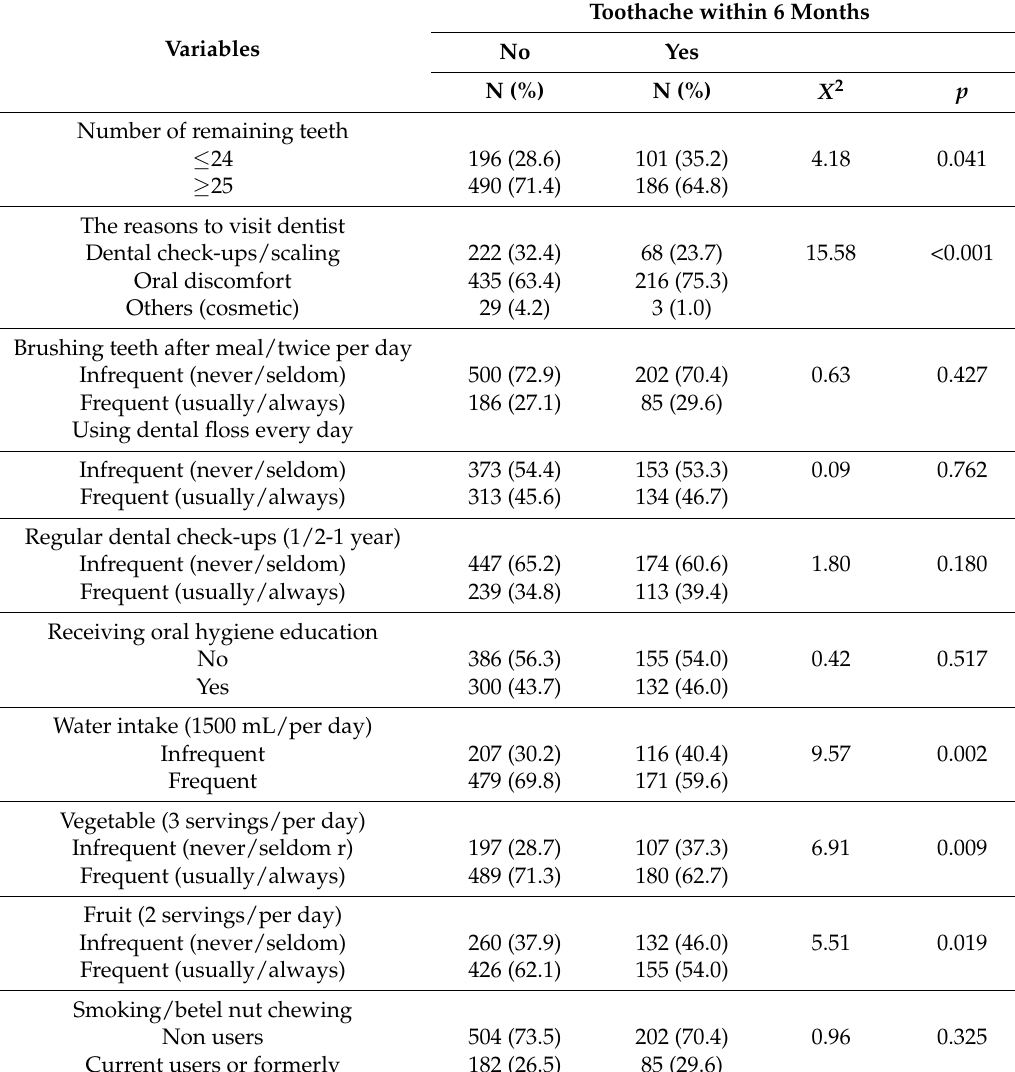
Table 2. Toothache within 6 month and health-related behaviors (N =